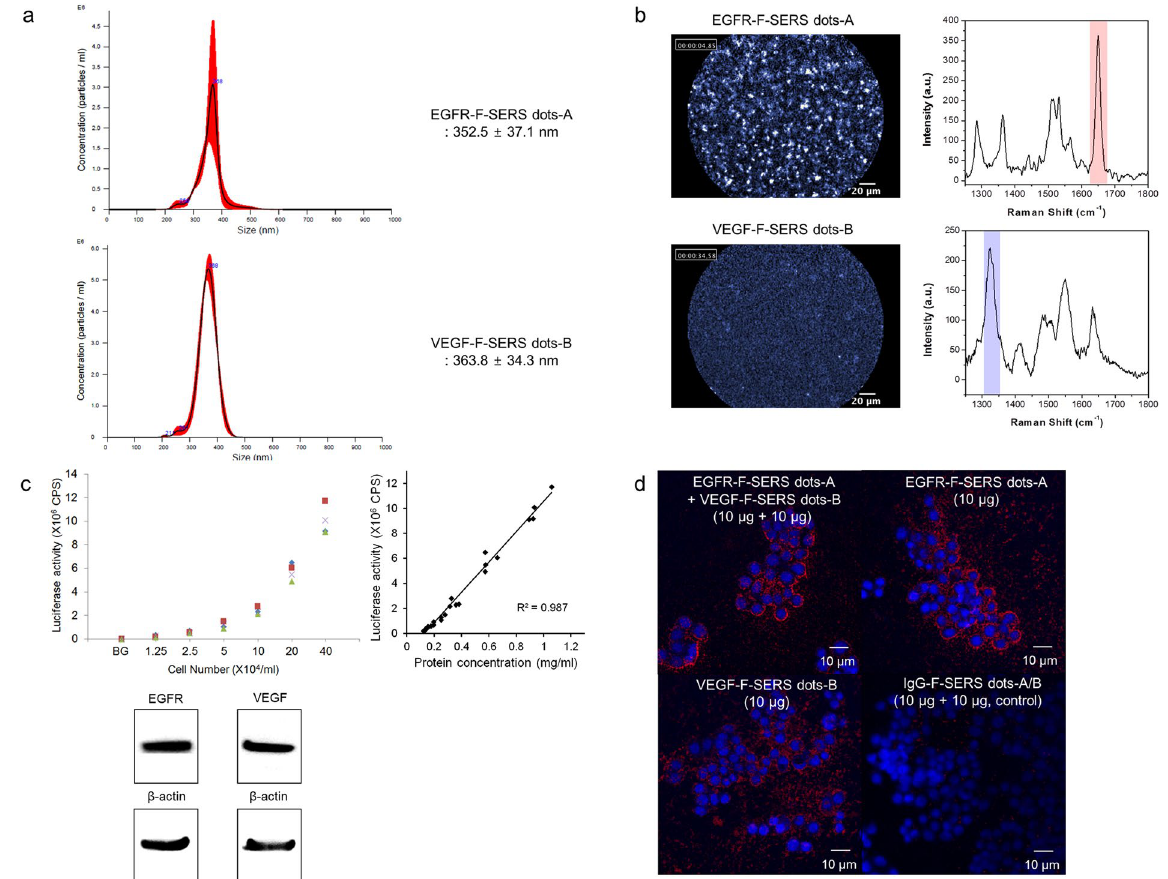
Figure 2. Characterization of fluorescence and surface enhanced Raman scattering nanoprobes (F-SERS dots), FRES, and colon cancer cell lines. ( a ) The size of the F-SERS and antibody-conjugated F-SERS dots. The size of the F-SERS-A and EGFR-F-SERS-A dots was 318.6 ± 20.1 nm and 352.5 ± 37.1 nm, respectively, and the size of the F-SERS-B and VEGF-F-SERS-B dots were 326.3 ± 25.9 nm and 363.8 ± 34.3 nm, respectively. ( b ) Evaluation of FRES using antibody-conjugated F-SERS dots. EGFR-F-SERS-A dots showed a small dotted fluorescence signal (AF 610) and a 1648 cm − 1 intensity Raman signal (RITC).VEGF-F-SERS-B dots revealed small dotted fluorescence signals (AF 610) and a 1324 cm − 1 intensity Raman signal (FITC) (a.u. = arbitrary unit). ( c ) Characterization of HT29-effluc colon cancer cells. HT29-effluc cells showed high luciferase activity according to seeded cell number and a significant positive correlation with protein concentration (R 2 = 0.987, P < 0.001). HT29-effluc cells demonstrated EGFR and VEGF expression by western blot analysis (the loading control used was β -actin; CPS = count per sec). ( d ) Confocal laser scanning microscopy (CLSM) after spraying 10 µ g of antibody-conjugated F-SERS dots onto cultured HT29-effluc cells. Multiple (EGFR-F-SERS-A and VEGF-F-SERS-B) or single (EGFR-F-SERS-A or VEGF-F-SERS-B) spraying of antibody-conjugated F-SERS dots were revealed by fluorescence, while the IgG-F-SERS-A/B dots (control) showed no fluorescence. Cell nuclei were labeled with